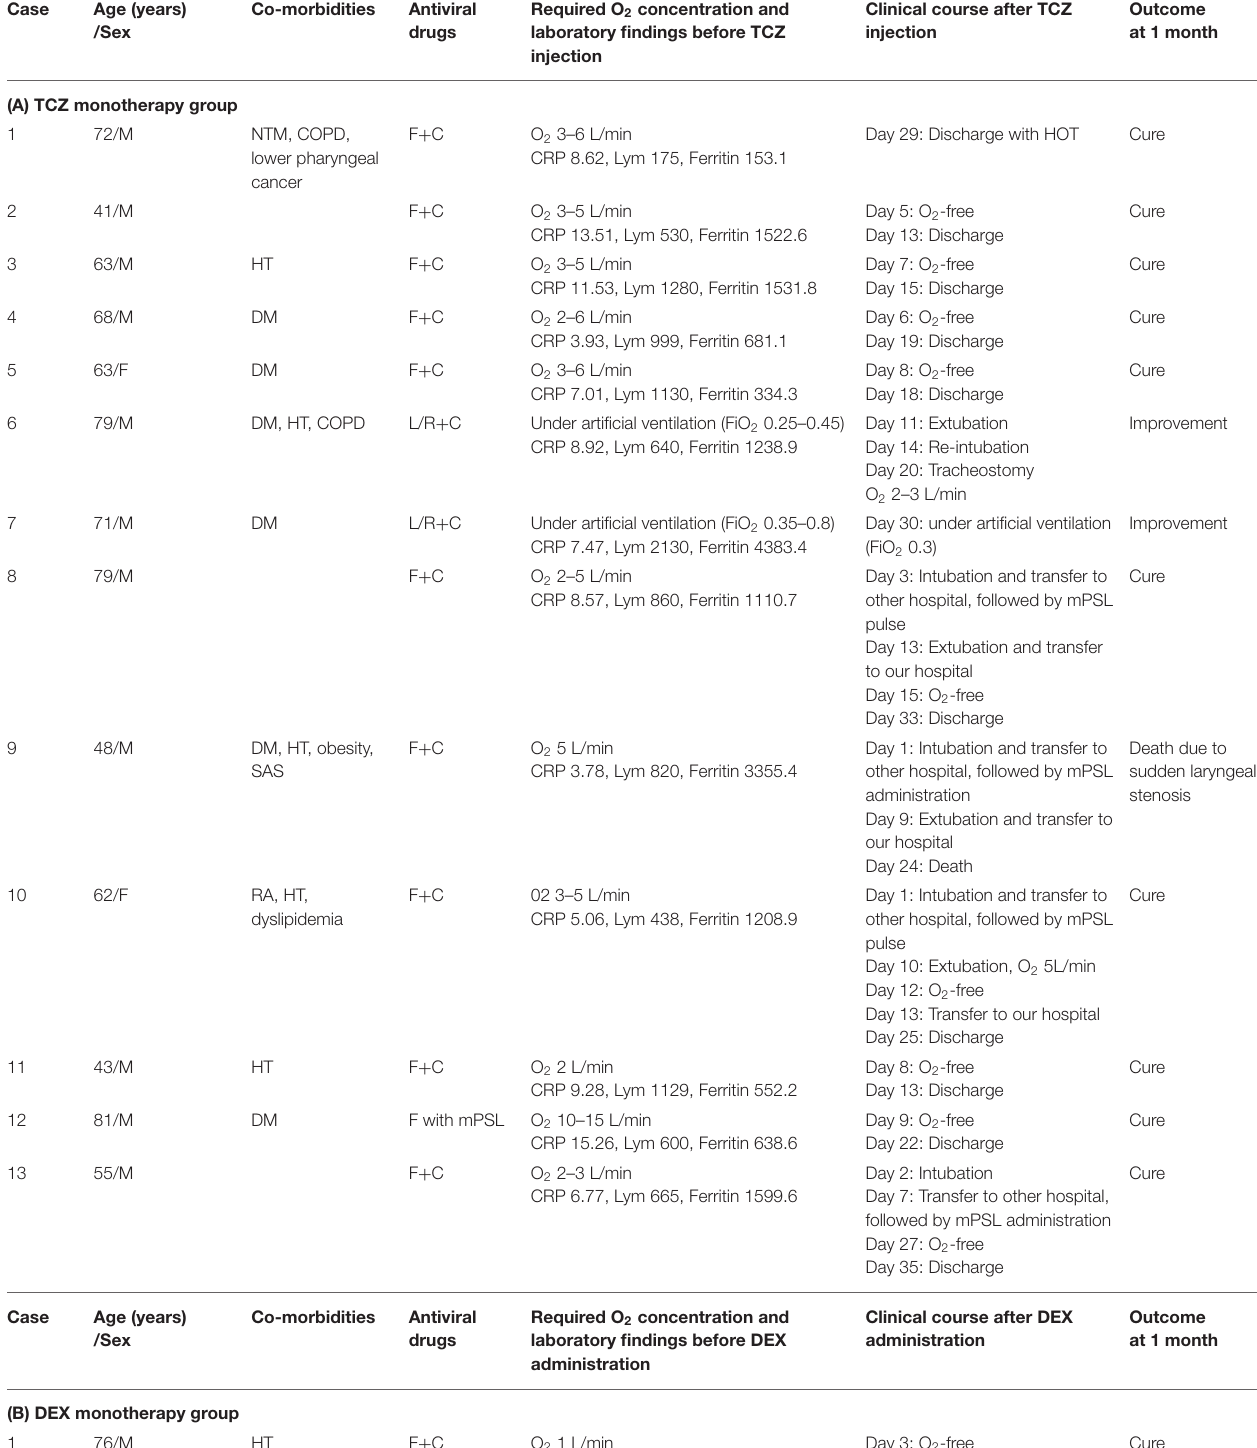
TABLE 1 | Characteristics and clinical course of patients with COVID-19 treated with tocilizumab, dexamethasone or dexamethasone followed by tocilizumab. Case Antiviral